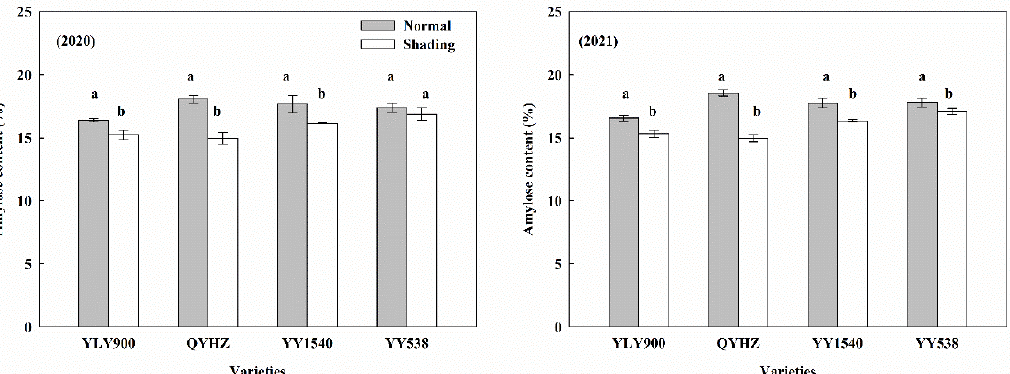
Figure 3. Amylose content of different rice varieties under shading after flowering in 2020–2021. YLY900 (Y-liangyou 900); QYHZ (Quanyouhuazhan); YY1540 (Yongyou 1540); YY538 (Yongyou 538). Different lowercase letters indicate significant differences at p < 0.05 between normal and shading according to LSD at 0.05 level.